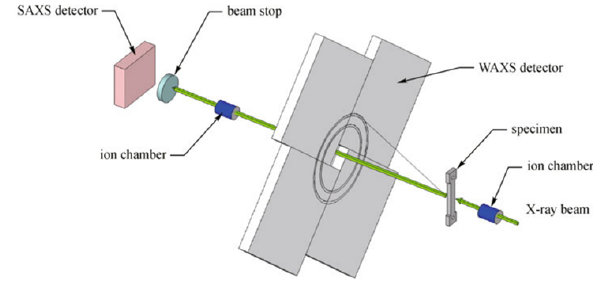
Figure 12: Scheme for simultaneous WAXS/SAXS at 1-ID beamline at APS